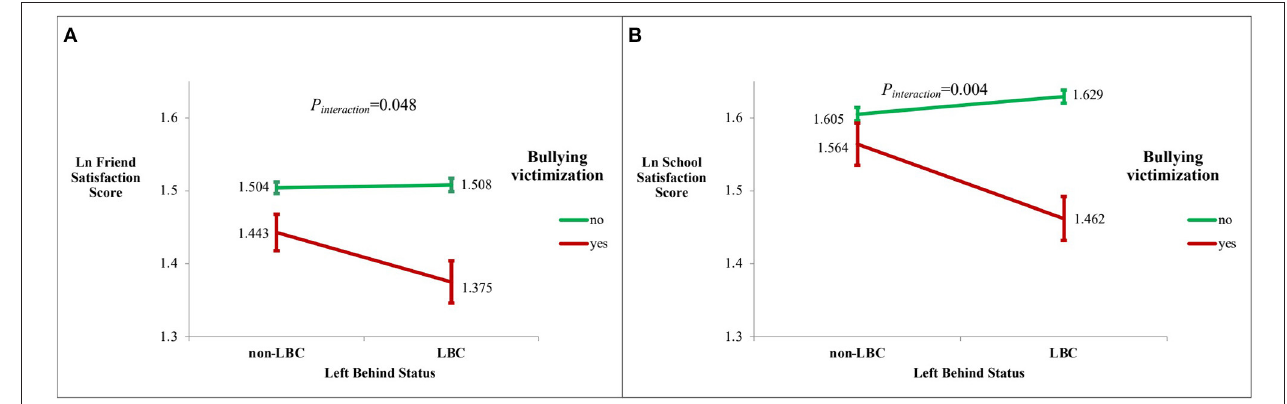
FIGURE 1 | Adjusted means and standard errors of Ln friend and school satisfaction scores stratified by left-behind status and bullying victimization. LBC: left-behind children. Non-LBC: non-left-behind children. Adjusted means and standard errors were estimated under general linear regression model with adjustment for age, ethnicity, and sex. (A) Friend satisfaction score and (B) school satisfaction